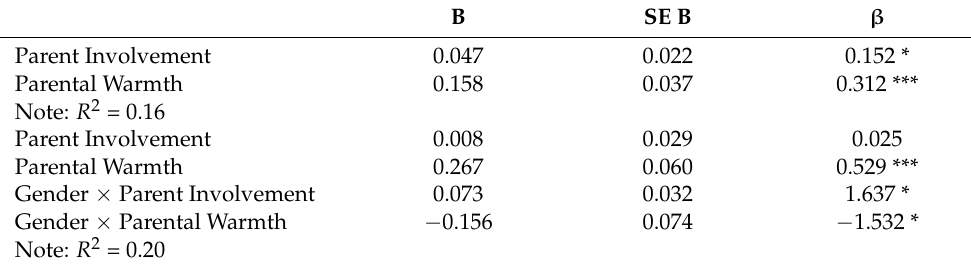
Table 7. Regression with moderators—academic